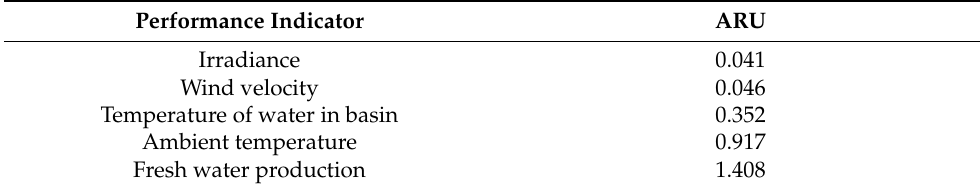
Table 4. The required parameters for the calculation of